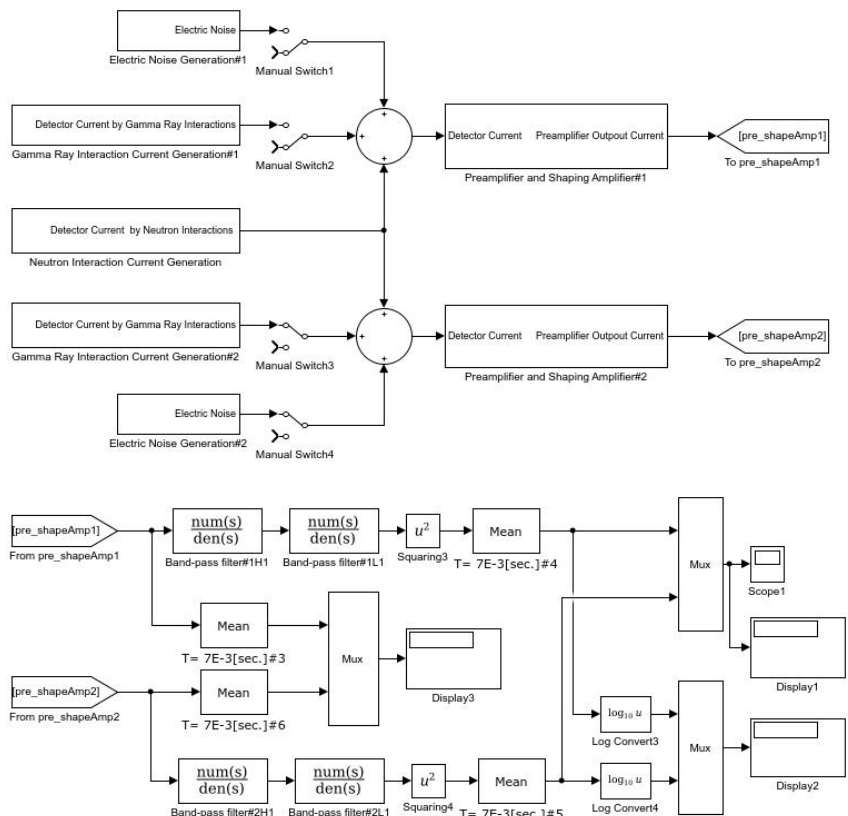
Figure 6. Block diagram of the MSV and current mode signal processing simulation.